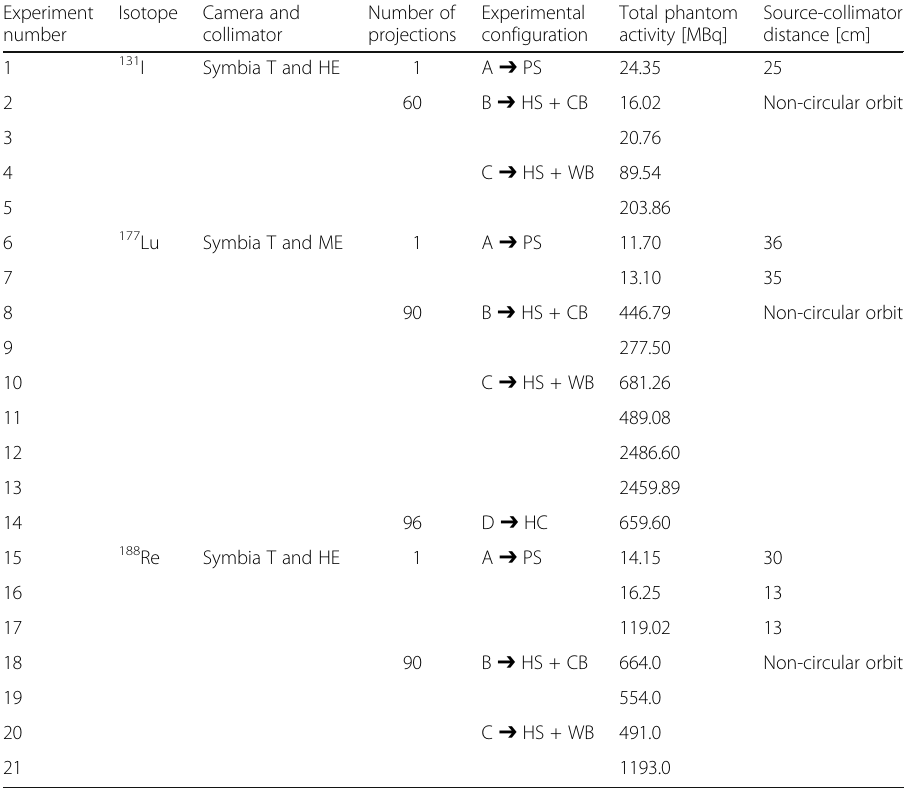
Table 2 Parameters of acquisitions and source activities used in phantom experiments Experiment Isotope Camera and number